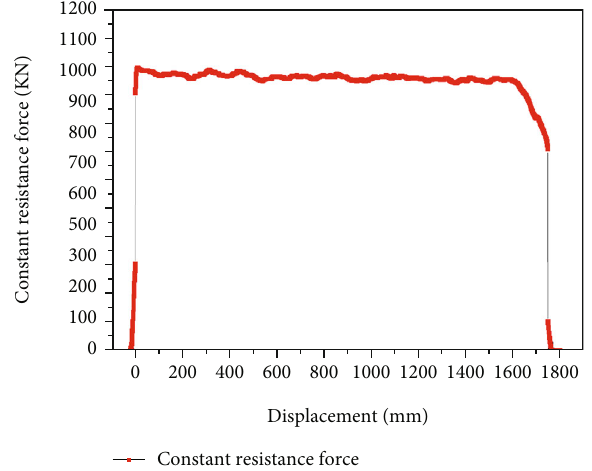
Figure 4: Static tension curve of CR cable